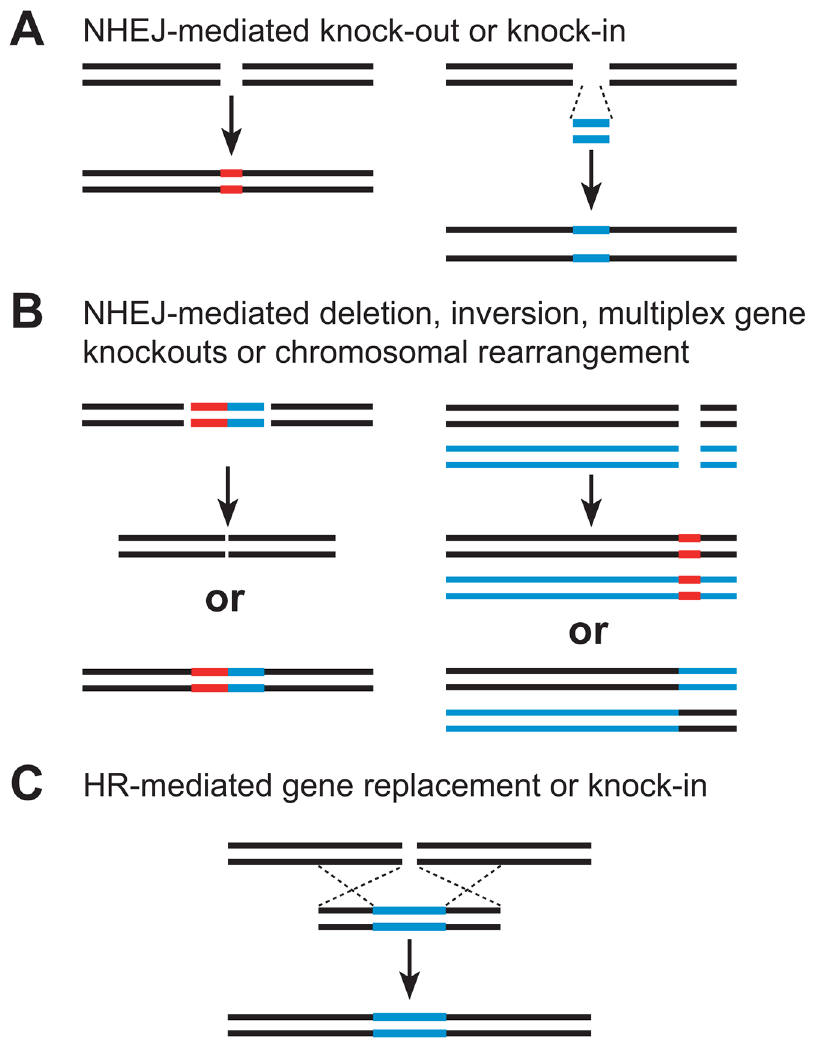
Figure 2. Targeted genome engineering by non-homologous end-joining or homologous recombination using sequence-specific nucleases. (A) NHEJ-mediated repair can result in small deletions or insertions at the target sites that can disrupt gene function (knock-outs, left). DNA fragments can be inserted via NHEJ-mediated ligation to create targeted insertions (knock-ins, right). (B) When two cuts are made by SSNs, NHEJ-mediated repair can result in either deletions or inversions of large genomic regions (left) or targeted gene deletions or chromosomal translocations (right). (C) HR-mediated repair, involving a homologous DNA template, leads to gene replacement or gene